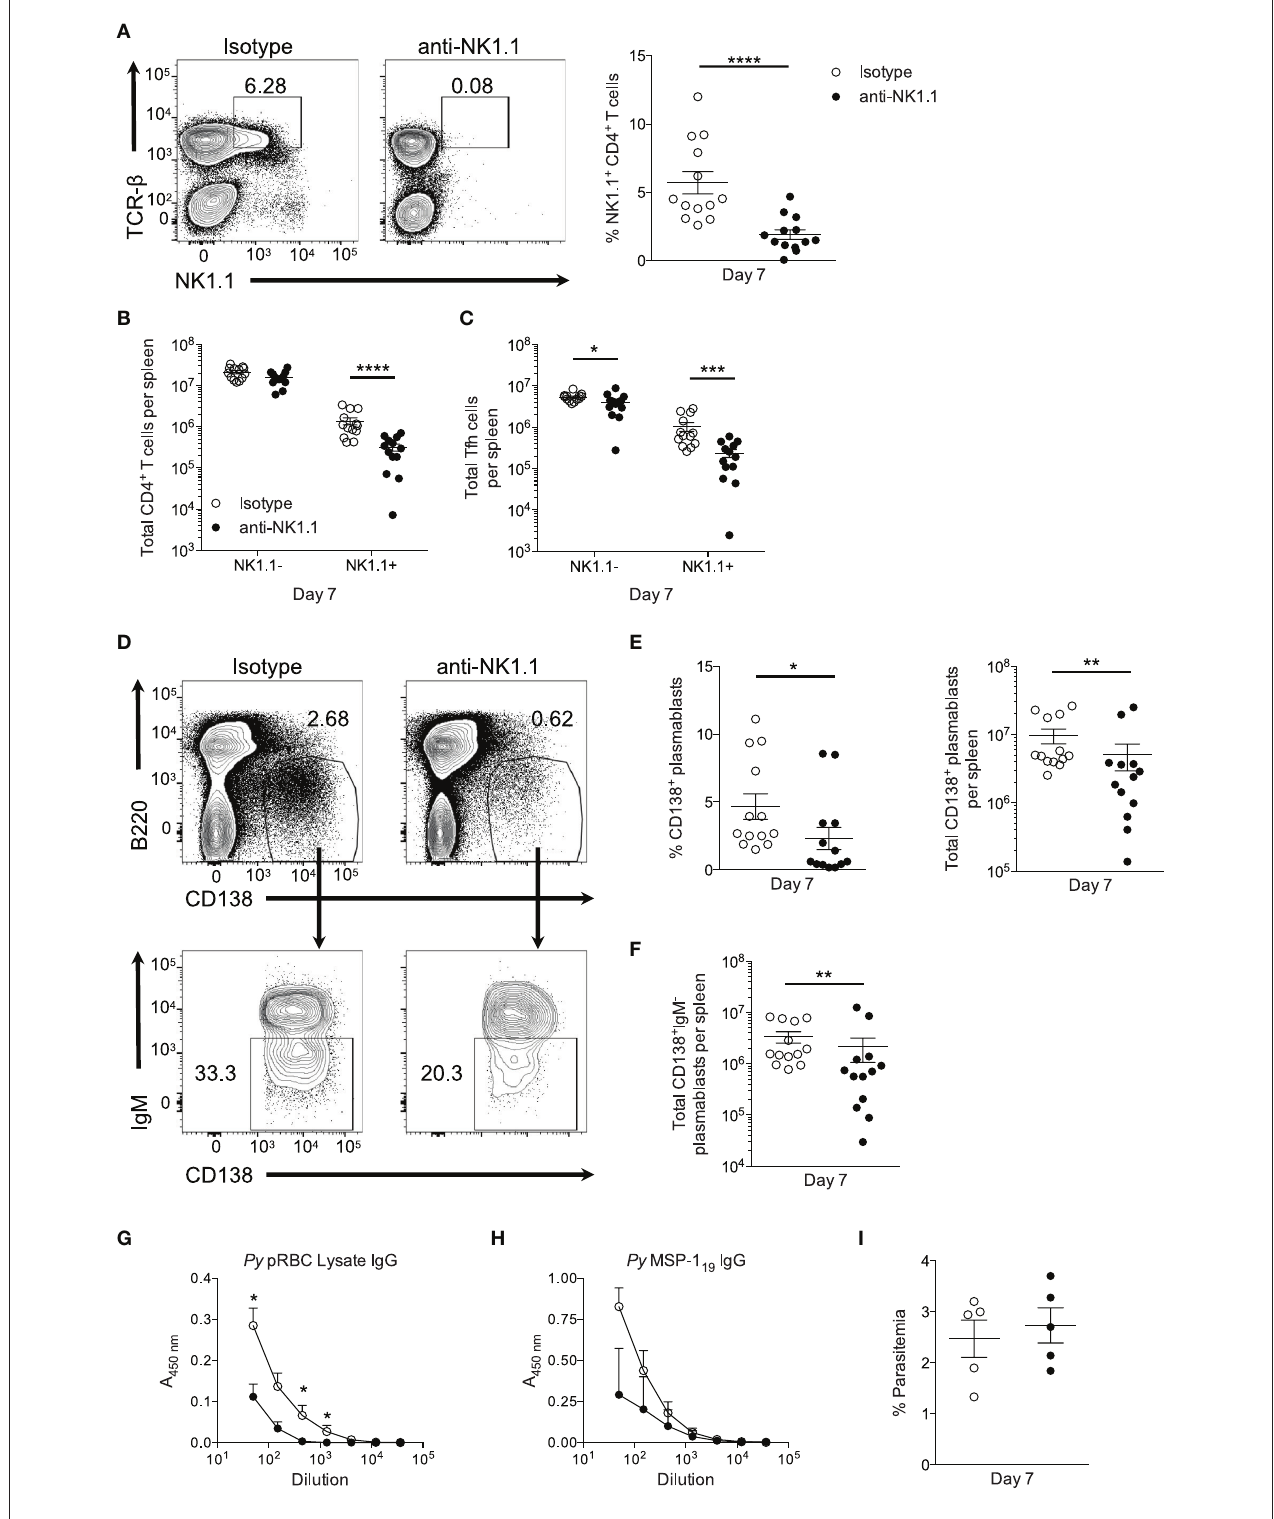
FIGURE 7 | Depletion of NK1.1 + CD4 + T cells inhibits parasite-specific Ab production. (A) The frequency of NK1.1 staining of live TCR- β hi NK1.1 + CD4 + T cells in isotype control or anti-NK1.1 Ab-treated mice at day 7 post-infection. (B) Total number of live splenic NK1.1 positive or negative CD4 + TCR β hi T cells in